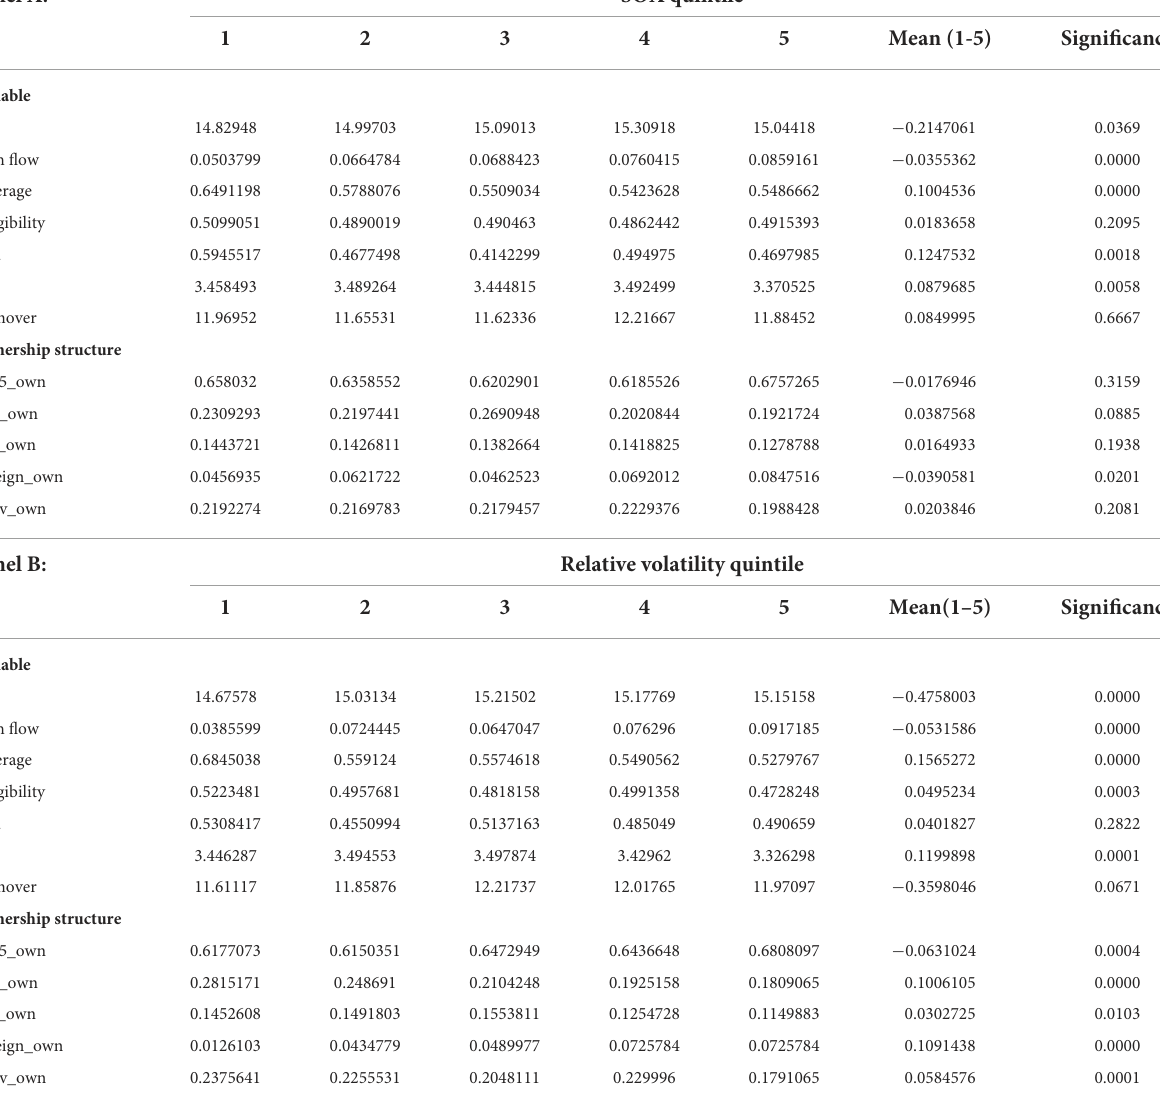
TABLE 5 Firm characteristics across dividend smoothing